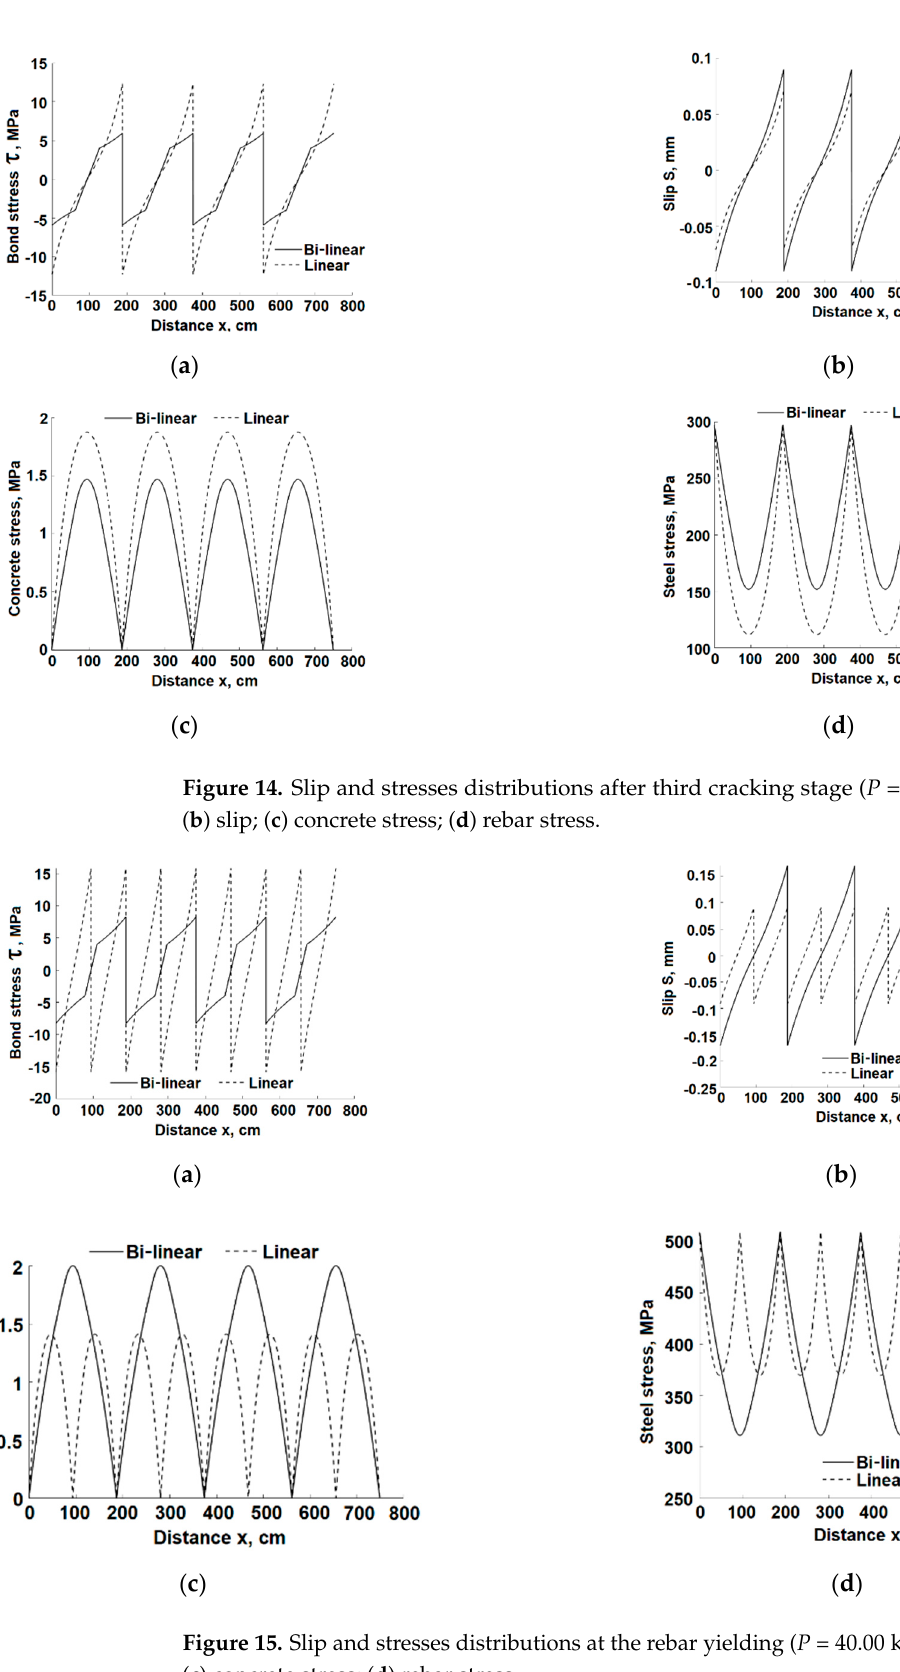
( b ) Figure 16. Boundary 𝒙(cid:3365) between the 1st and second bond-slip zones. ( a ) dependence on tensile load; ( b ) dependence on the bar length. 5. Summary and Conclusions This paper presents an extended formulation of the 1-D tension stiffening problem implementing a bi-linear bond-slip model to allow coverage of a large range of loading and follow cracks growth until reaching their maximum allowable width. Assuming lin- ear elastic behavior of the rebar in tension, only the nonlinear bond-slip relationship and the variation of topology due to cracking development are responsible for the non-linear behavior.